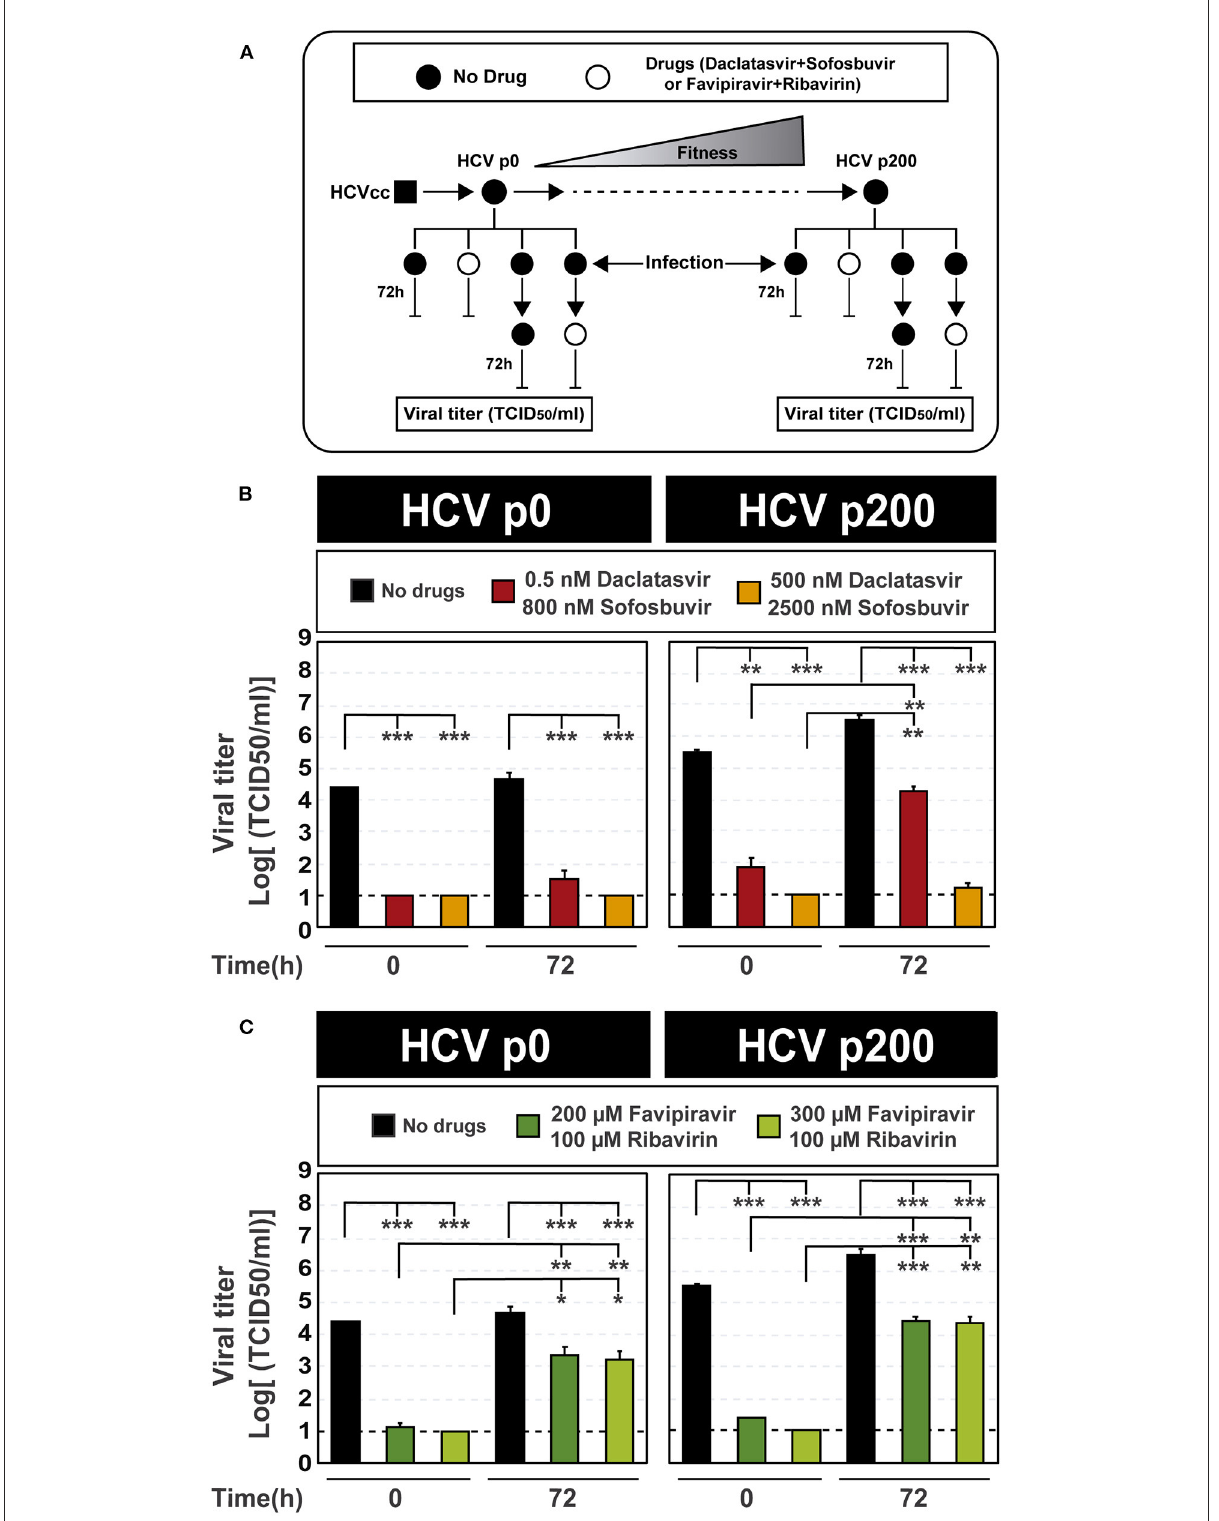
FIGURE3 Inhibition of HCV infectious progeny production by combinations of antiviral agents added at the time of infection or 72h post-infection. (A) Scheme of the experiment displaying at the top the evolution of HCV p0 toward its high fitness derivative HCV p200. The time of infection and of addition of the antiviral inhibitors are indicated next to the vertical lines; in all cases, virus titer in the cell culture supernatant was determined